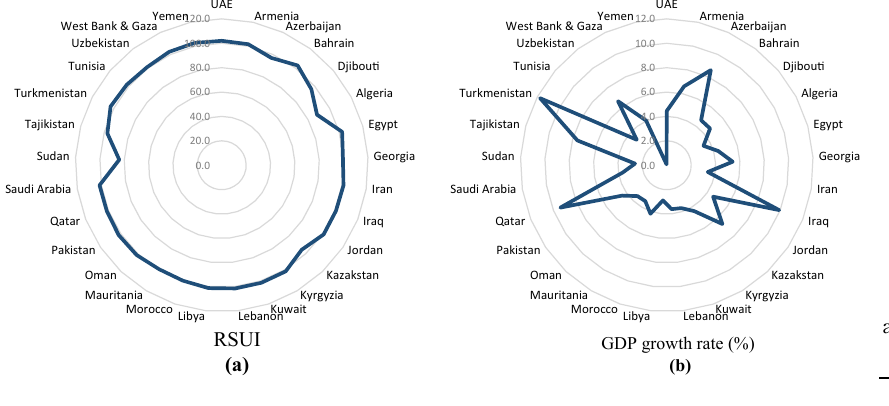
Figure 1. Average RSUI